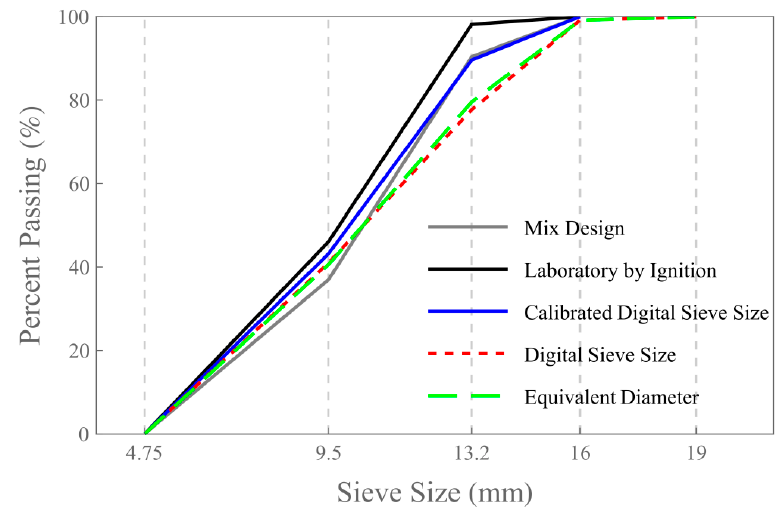
Figure 11. Gradation curves for Specimen 1.